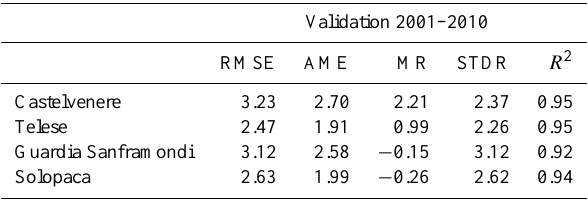
Table 7. Error statistics of T a estimates against observations at the available stations.